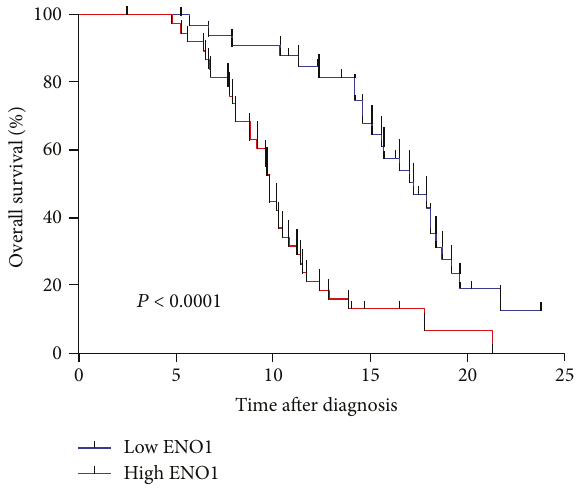
Figure 3: Overall survival curve with median value as cuto ff for ENO1 represented the association between the plasma ENO1 level and prognosis of PDAC patients.